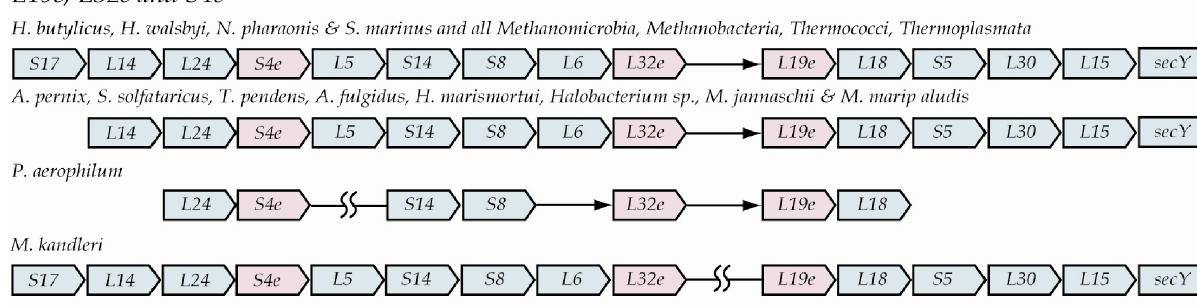
Figure 2. Alternative versions of the spc gene cluster in the Archaea. Labeling conventions are as in Figure 1. In addition, a double broken line in- dicatesa majorgap such thatthetwo groupsof genesseparatedby thegap arenotinthesamevicinityof thegenome. Itshouldbe notedthattherel- ative transcription directions indicated pertain only to members of each group not to the relative orientations between the groups. Thus, the two large subclustersindicated in M. kanderleri are in fact separated in the genome where they occur on opposite strands with transcriptionin opposite directions. This cluster always contains the archaeal-specific r-protein genes for L19e, L32e and